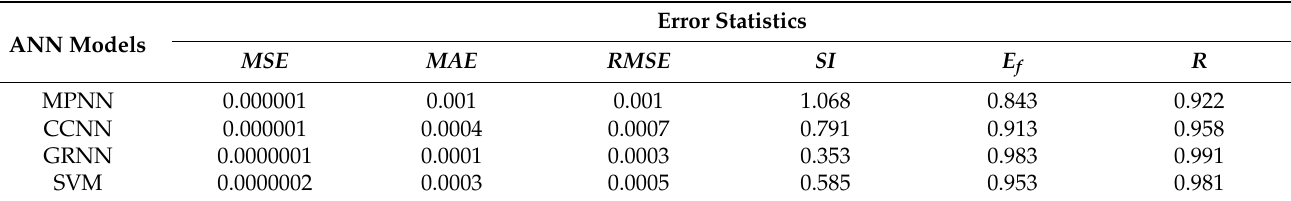
Table 8. Error statistics for different ANN and SVM models.